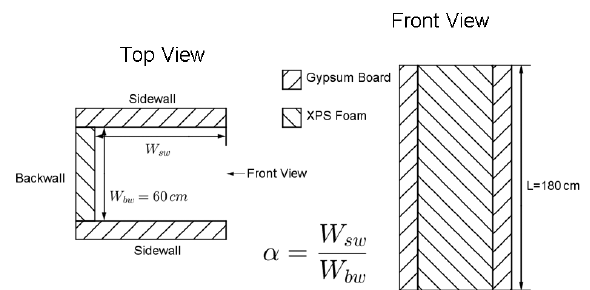
Fig. 3. Illustration of definition of geometrical factor